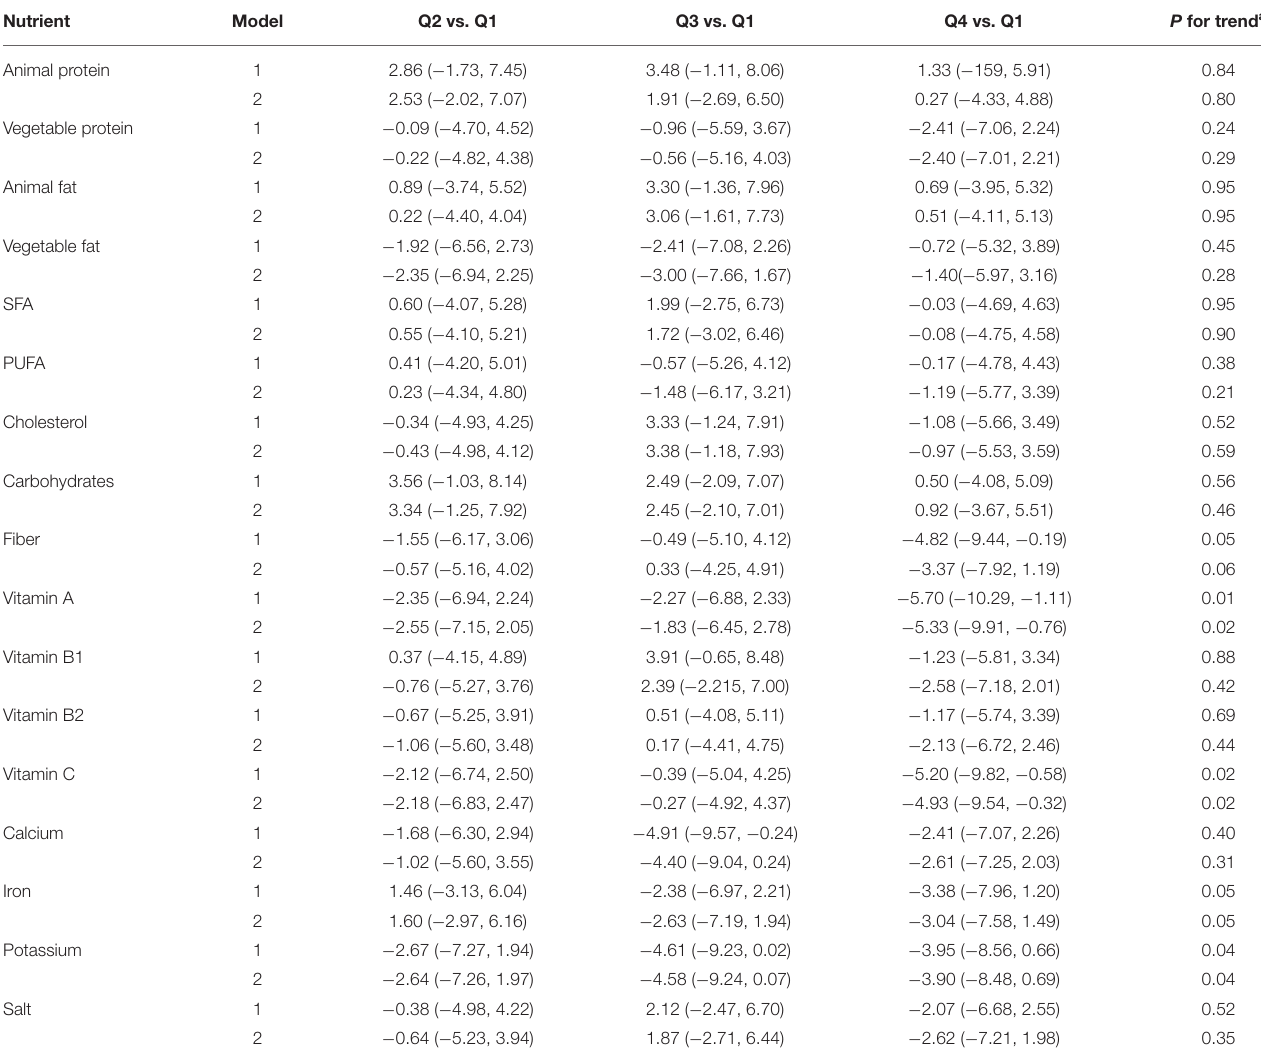
TABLE 5 | Mean CRVE ( µ m) differences across quartiles of energy-adjusted nutrient intake compared with the lowest quartiles. Nutrient Model Q2 vs. Q1 Q3 vs. Q1 Q4 vs. Q1 P for trend